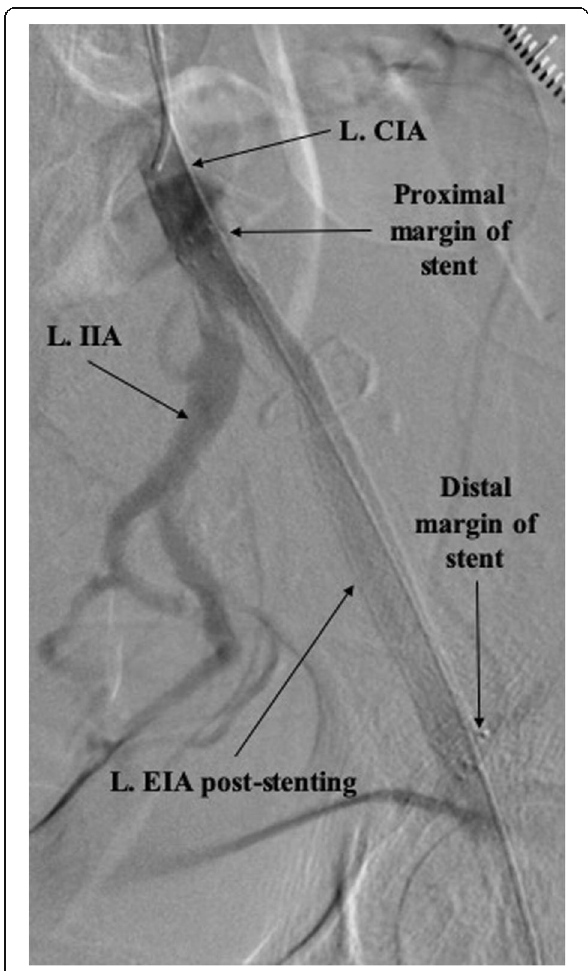
Fig. 4 Post-intervention angiogram showing a patent left external iliac artery (L. EIA) stent as well as the proximal and distal margins of the stent. (L. CIA, left common iliac artery; L. IIA, left internal iliac